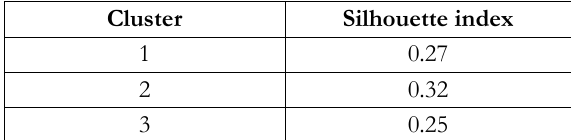
Table 2. Silhouette index obtained by clusters